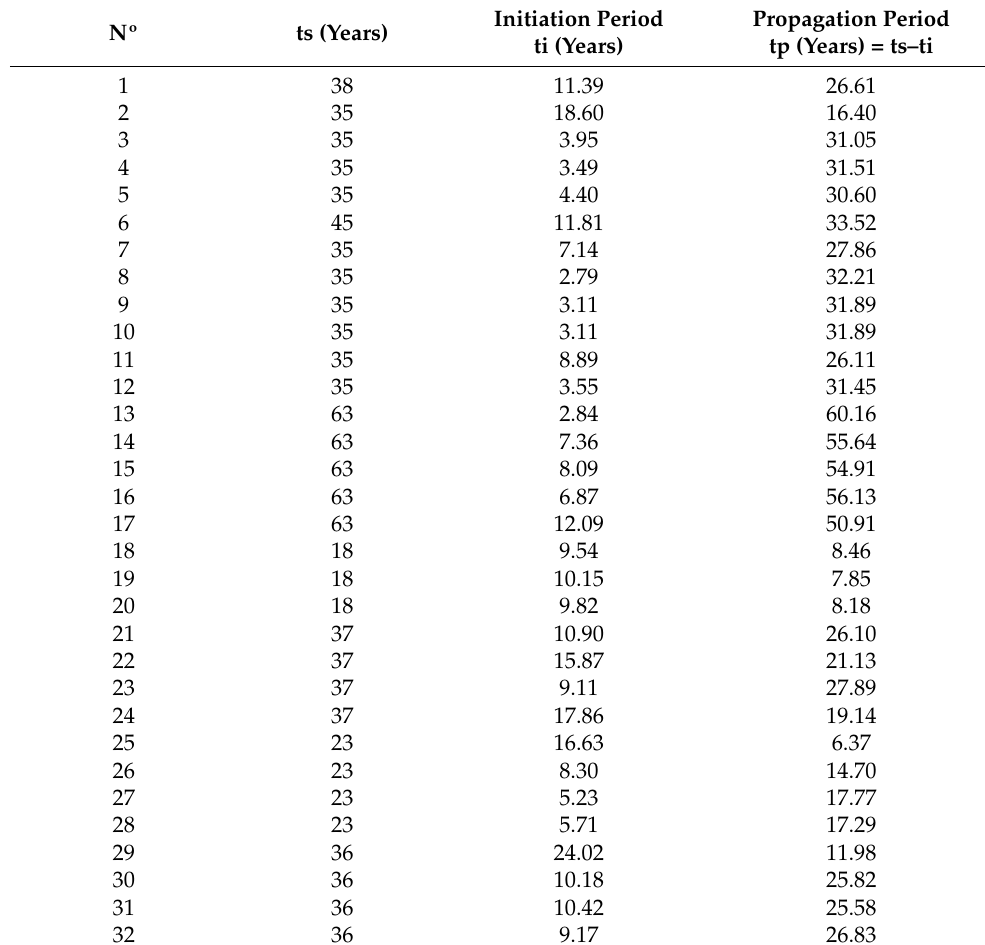
Table 4. Propagation period results for each of the case studies. Calculated from the age of the structure at the time of the durability study ( ts ) and the initiation period ( ti ).